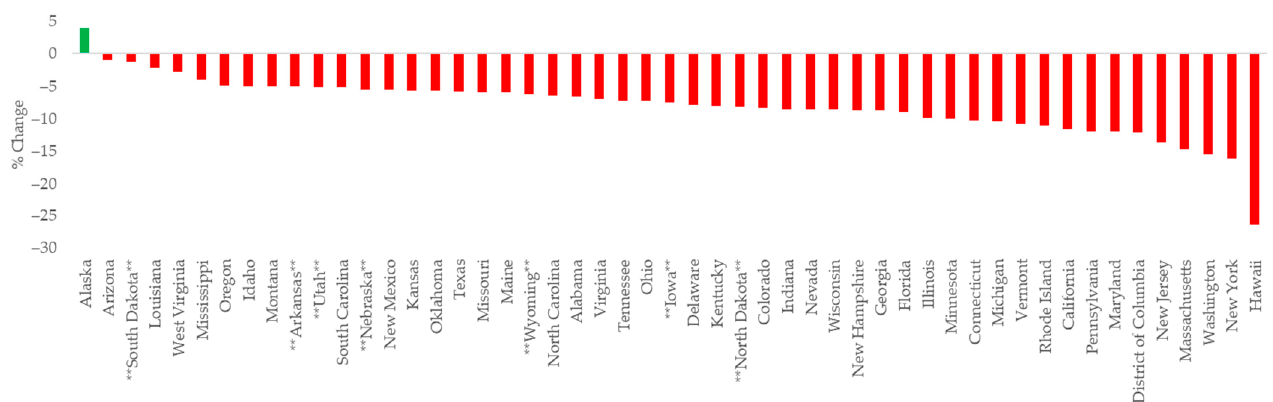
Figure 6. The 2019–2020 percent change in state-wise per capita energy consumption, sorted [30].